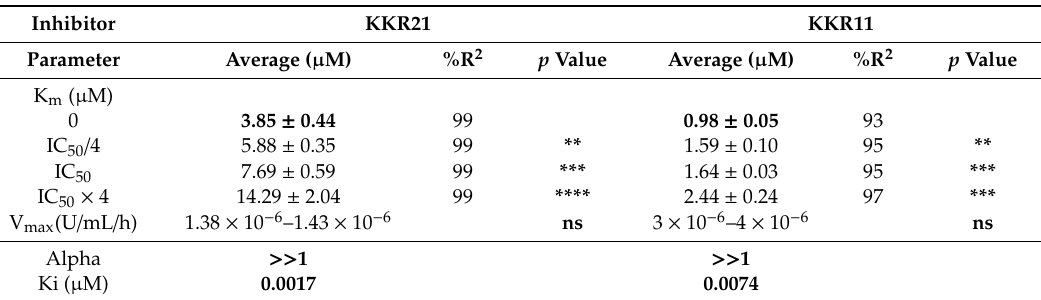
Table 2. The e ff ects on enzyme maximum velocity (V max ) and the Michaelis constant (K m ) average values with increasing KKR concentration: X-intercepts of the KKR linear regressions represent the K m value changes; and the Y-intercepts of the KKR linear regressions (minimum and maximum average means shown) represent the V max value